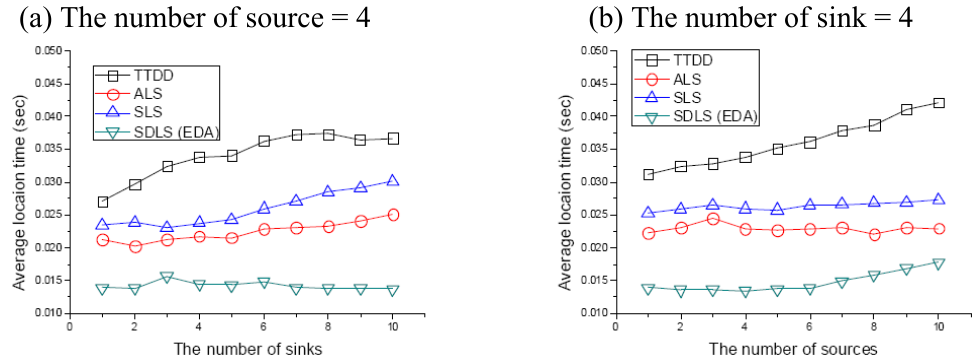
Figure 7. Location response time from anchor